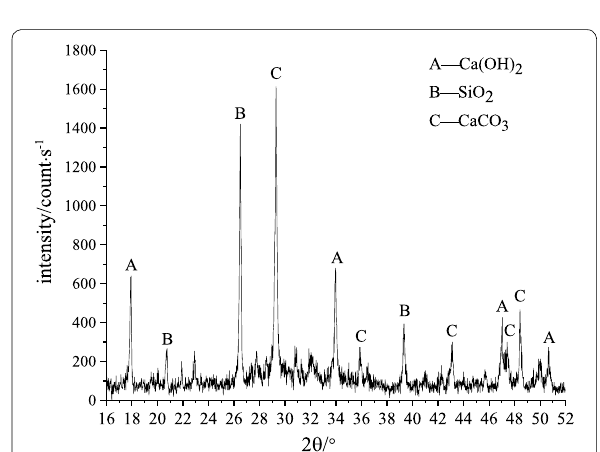
Fig. 18 X-ray analysis of specimen T5 at room